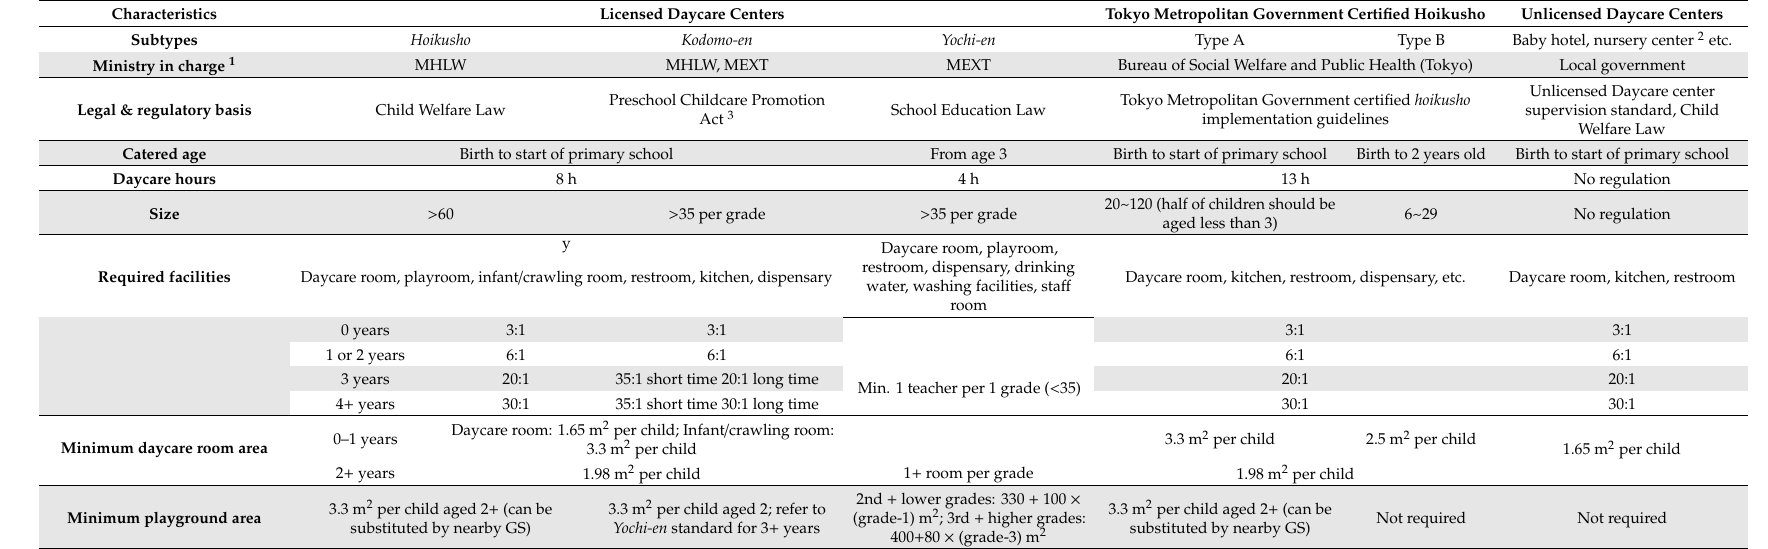
Table 1. Major types of daycare centers in Japan and their characteristics (adapted from